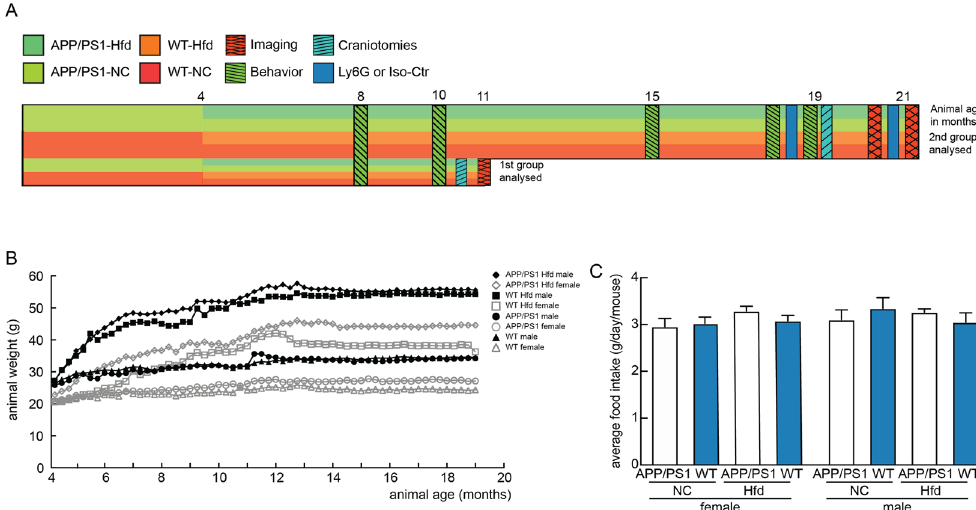
Figure 1. Experimental design/timeline, and animal weight gain and food consumption. ( A ) Schematic illustrating animal groups, timeline, measurements, and interventions. APP/PS1 and WT mice were allocated to a high fat diet (Hfd) or normal chow (NC) at 4 months of age. Animals received behavioral testing multiple times, as indicated. A small cohort from all four groups received cranial windows and cortical imaging at 11 months of age. The remaining cohort received additional behavioral testing, including before and after administration of α -Ly6G at 19 months, and then received cranial windows and were imaged before and after α -Ly6G treatment. All experimental groups were kept on their diet continuously from four months of age until euthanasia. ( B ) Average mouse weight for each group as a function of animal age, beginning at 4 months of age, distinguishing male and female mice in each group. ( C ) Average mass of food intake per mouse per day for all groups, distinguishing female (left) and male (right)